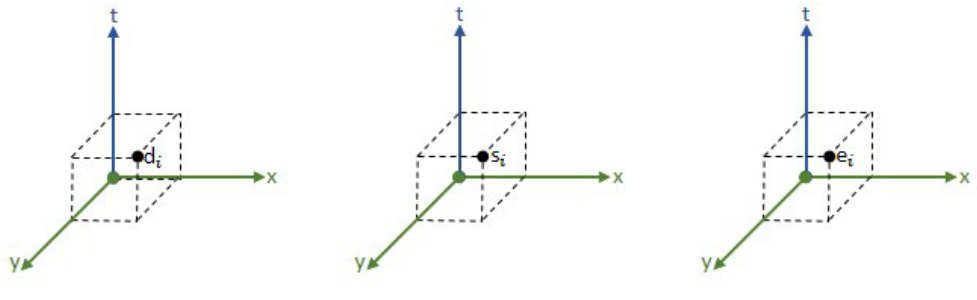
Figure 14. Spatiotemporal coordinates.